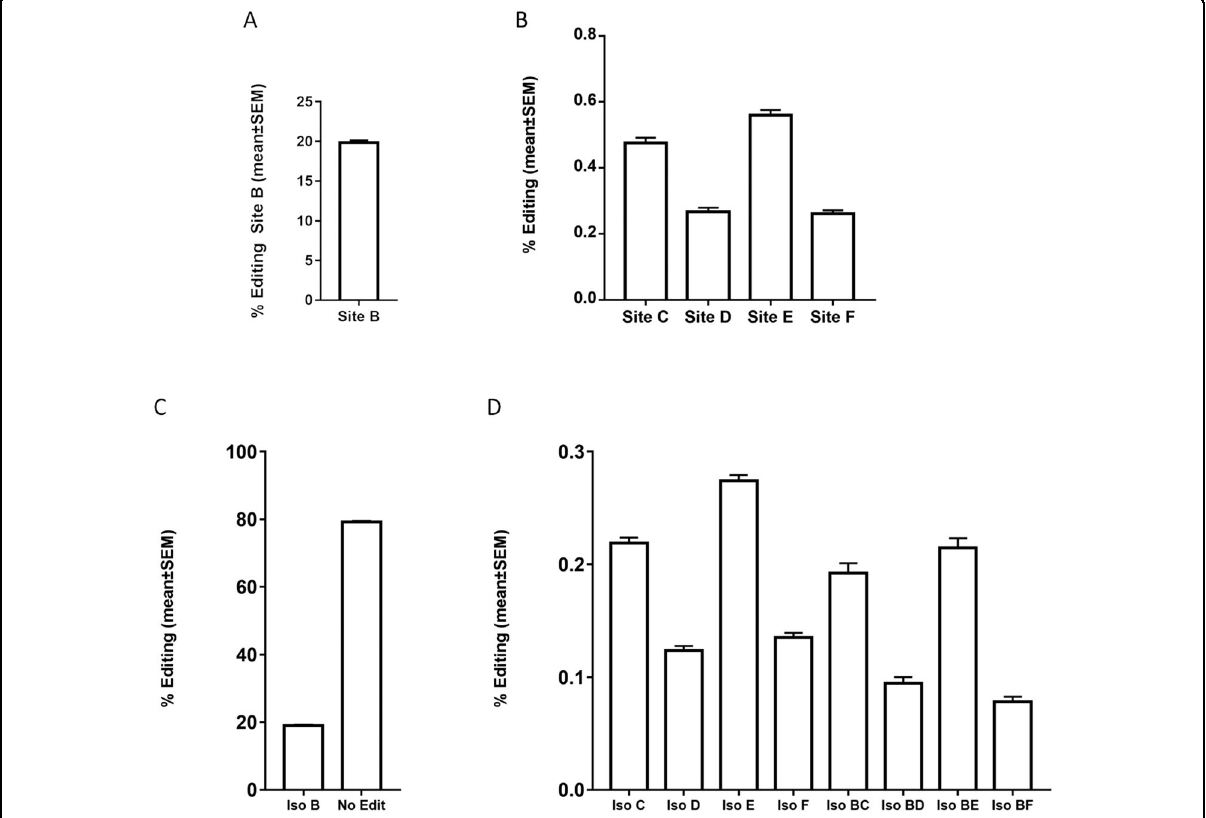
Fig. 1 Distribution of PDE8A mRNA sites and isoforms measured in whole blood on samples of the control group. Histograms represent relative editing proportion (%) of the detected PDE8A editing site ( A , B ) or isoform ( C , D ) (mean ± s.e.m.; n = 99). Only isoforms representing more than 0.1% of relative proportion were included in the